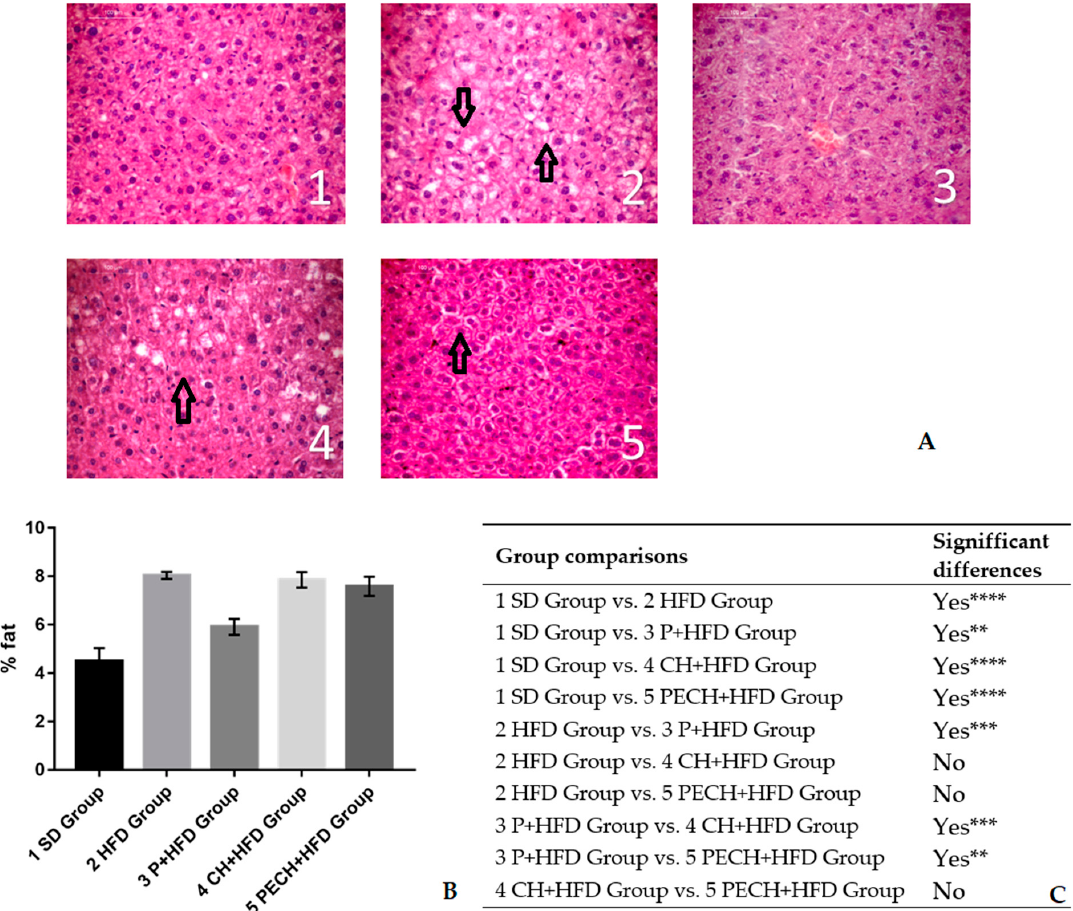
Figure 3. Effect of the different diets on the fat content in liver. ( A ) Liver cuts stained with hematoxylin-eosin. Non-stained areas correspond with lipid deposits between hepatocytes, pointed by black arrows. Numbers and groups correspond as following: (1) Standard diet, (SD), (2) high-fat diet (HFD), (3) phenolic-enriched high-fat diet (P + HFD), (4) lyophilized cooked ham enriched high-fat diet (CH + HFD) and (5) lyophilized phenolic enriched cooked ham enriched high-fat diet (PECH). ( B ) The graph shows total fat content in humid samples as %. ( C ) Statistical comparison. Significant differences are expressed as * p < 0.05 ** p < 0.01 *** p < 0.001 **** p < 0.0001.